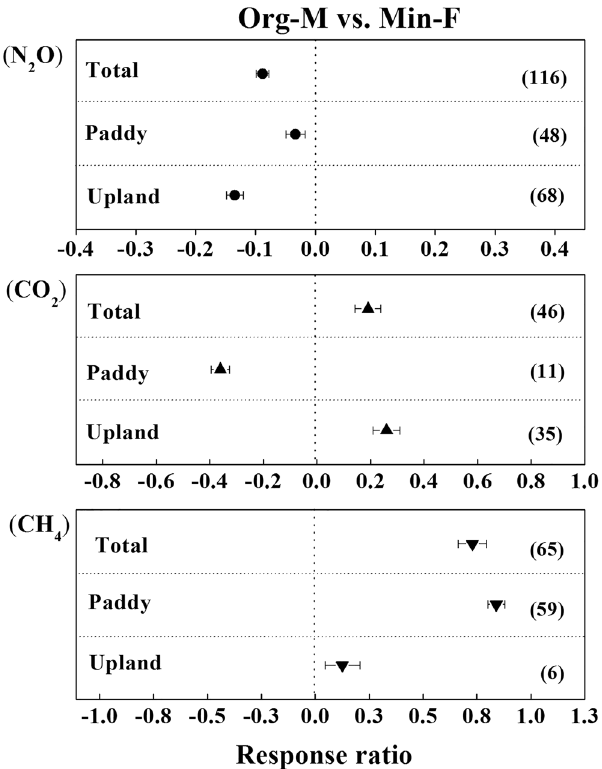
Figure 4. N 2 O, CO 2 and CH 4 emissions (CH 4 emission for paddies and uptake for upland) affected by manure application compared to chemical fertilizers with same amount of N input. P < 0.05, when error bars do not overlap